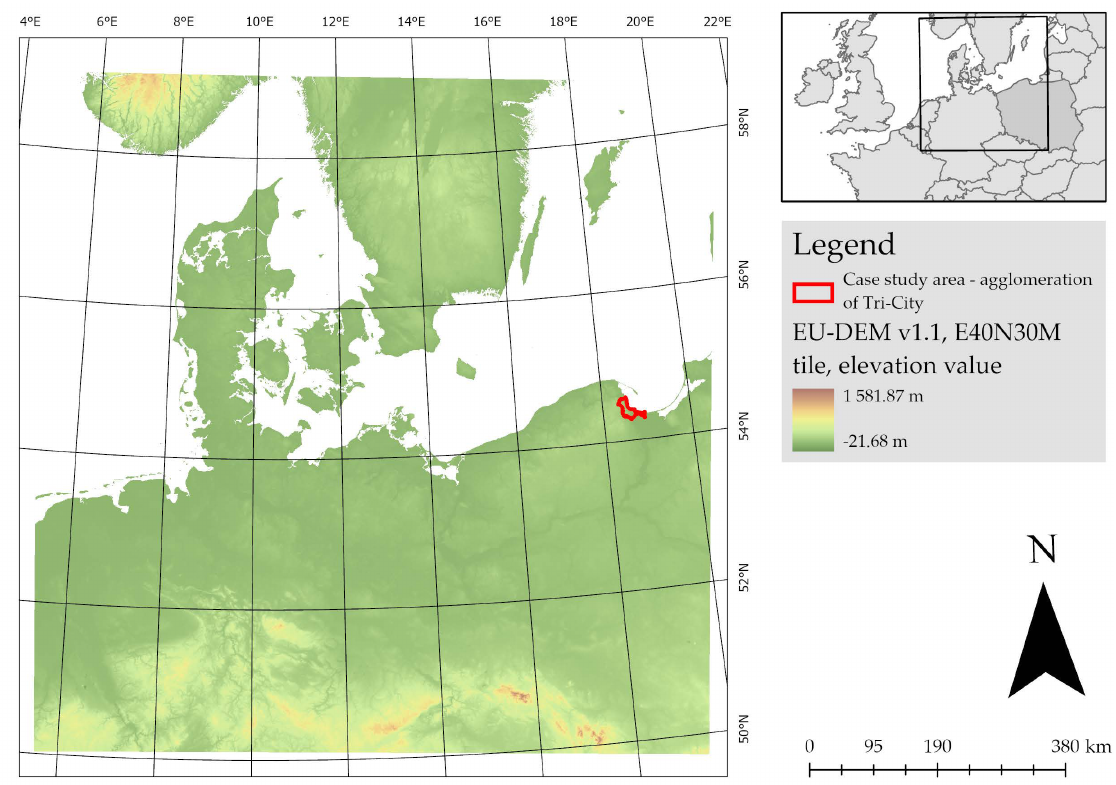
Figure 7. EU-DEM v1.1, E40N30M tile. Source: own elaboration, on the basis of Copernicus Land Monitoring Service [55].